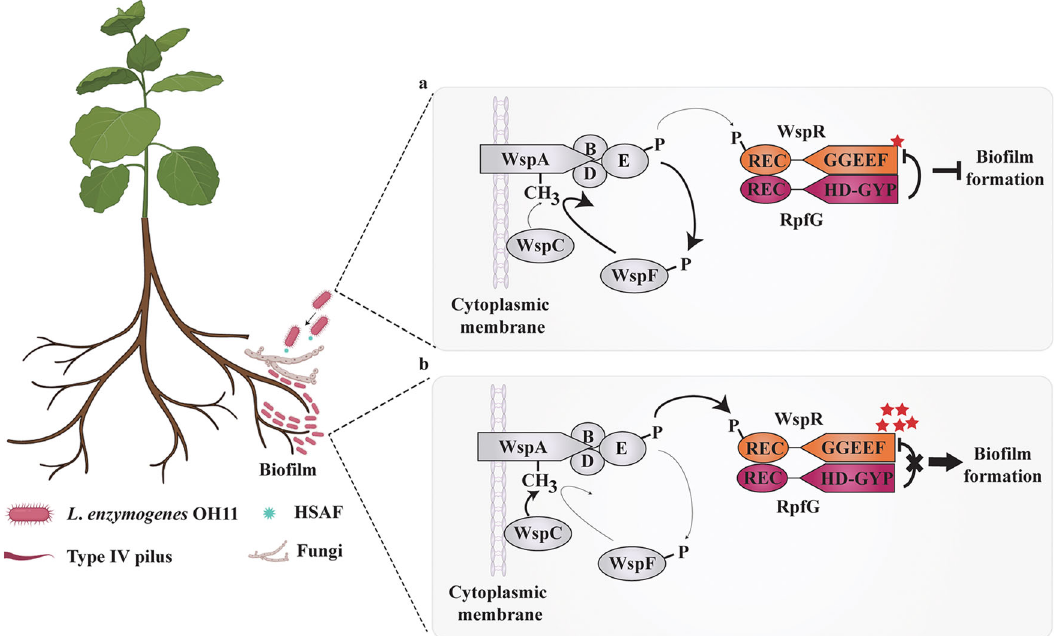
Fig. 7 The proposed model showing how the Wsp system controls c-di-GMP-dependent bio fi lm formation by integrating the DSF system in L. enzymogenes . Lysobacter enzymogenes OH11 is a member of the soil microbiome and a natural predator of fungal pathogens that infect crop roots. As previously described, in the presence of nearby fungal pathogens (dark lightening symbol), this bacterium most likely forms planktonic cells to facilitate its movement towards fungi via T4P and inhibit fungal growth by secreting the antifungal antibiotic HSAF 42 ,. a At this point, WspA, an MCP-like protein, blocks auto-phosphorylation of histidine kinase WspE by inhibiting WspC activity (thin dark arrows) and/or promoting the WspF activity (thick dark arrows), resulting in un-phosphorylated WspR that displays decreased DGC activity. Meanwhile, the active PDE RpfG of the DSF system can act as an adaptor protein to bind to WspR independent of its PDE activity and further inhibit its DGC activity, resulting in attenuated intracellular c-di-GMP levels, thereby inhibiting bio fi lm formation. b When L. enzymogenes cells attach to fungal hyphae in the root microenvironment, WspA appears to be in a methylation state by enhancing the WspC activity (a thick dark arrow) and/or inhibiting the WspF activity (a thin dark arrow) to stimulate the auto-phosphorylation of WspE, thereby producing phosphorylated WspR (WspR~P; thicker arrow). In this case, WspR~P not only impairs its binding af fi nity to RpfG, but also blocks the ability of RpfG to act as an adaptor protein to inhibit the DGC activity of WspR~P, resulting in elevated intracellular c-di-GMP concentration that promotes bio fi lm formation via bacterial colonization. This fi gure was created with